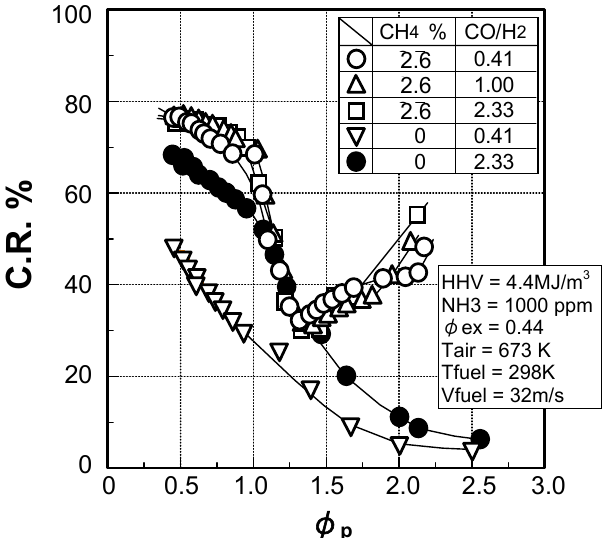
Figure 16. Influences of CO/H to NOx in two-stage NH 3